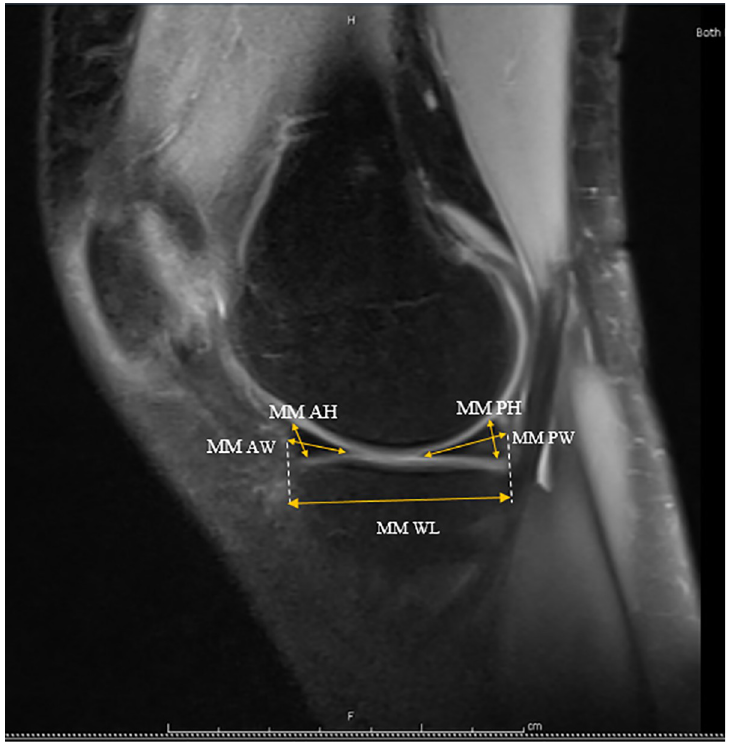
Fig 2. Mid-medial sagittal section (MM AH) Medial Meniscal Anterior Height (MM AW) Medial Meniscal Anterior Width (MM PH) Medial Meniscal Posterior Height (MM PW) Medical Meniscal Posterior Width (MM WL) Medial Meniscal Whole